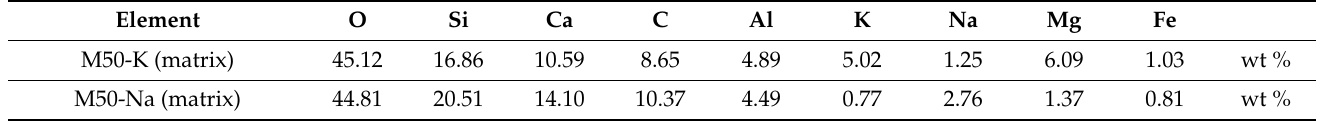
Table 6. EDS analysis of geopolymer matrix of M50-K and M50-Na.